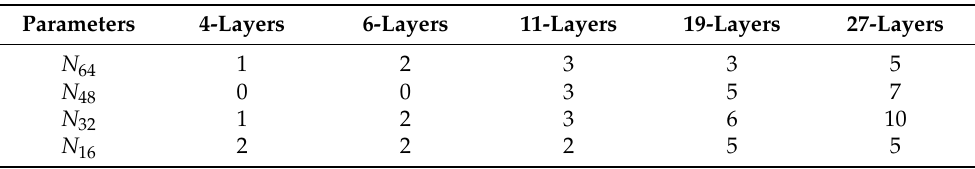
Figure 11. Our implementation for RLC-GNN architecture in experiments. d i and d o denote dimen- sions of input and output, respectively. See Table 1 for details of architectures. Table 1. Implementations for RLC-GNN with various number of layers. N d denotes the number of layers whose dimension of input node embeddings is d